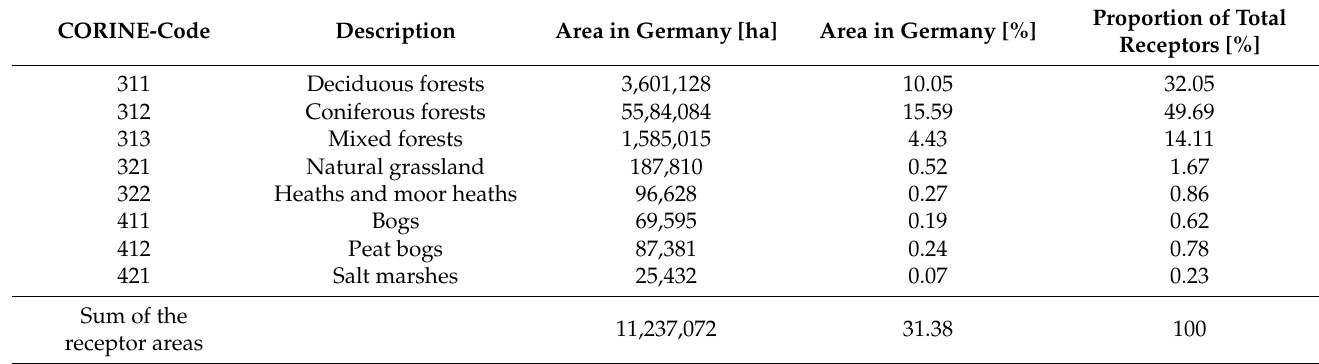
Table 1. Receptor types and their area shares according to CORINE 2012 [15] in